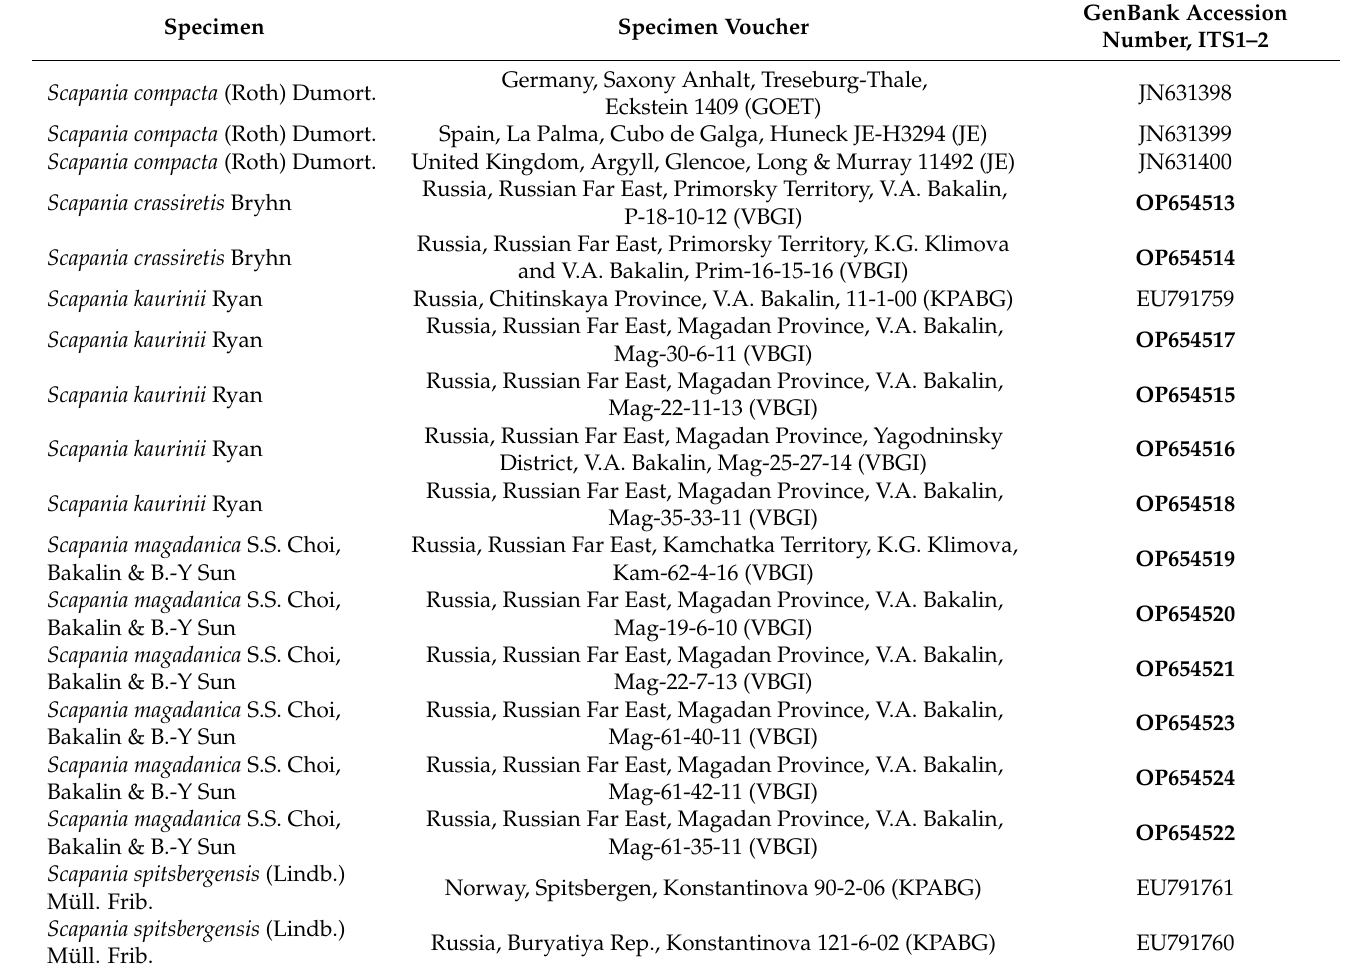
Table 1. The list of voucher details and GenBank accession numbers for the specimens used in phylogenetic analysis in the present paper. The newly obtained sequences are marked in bold.